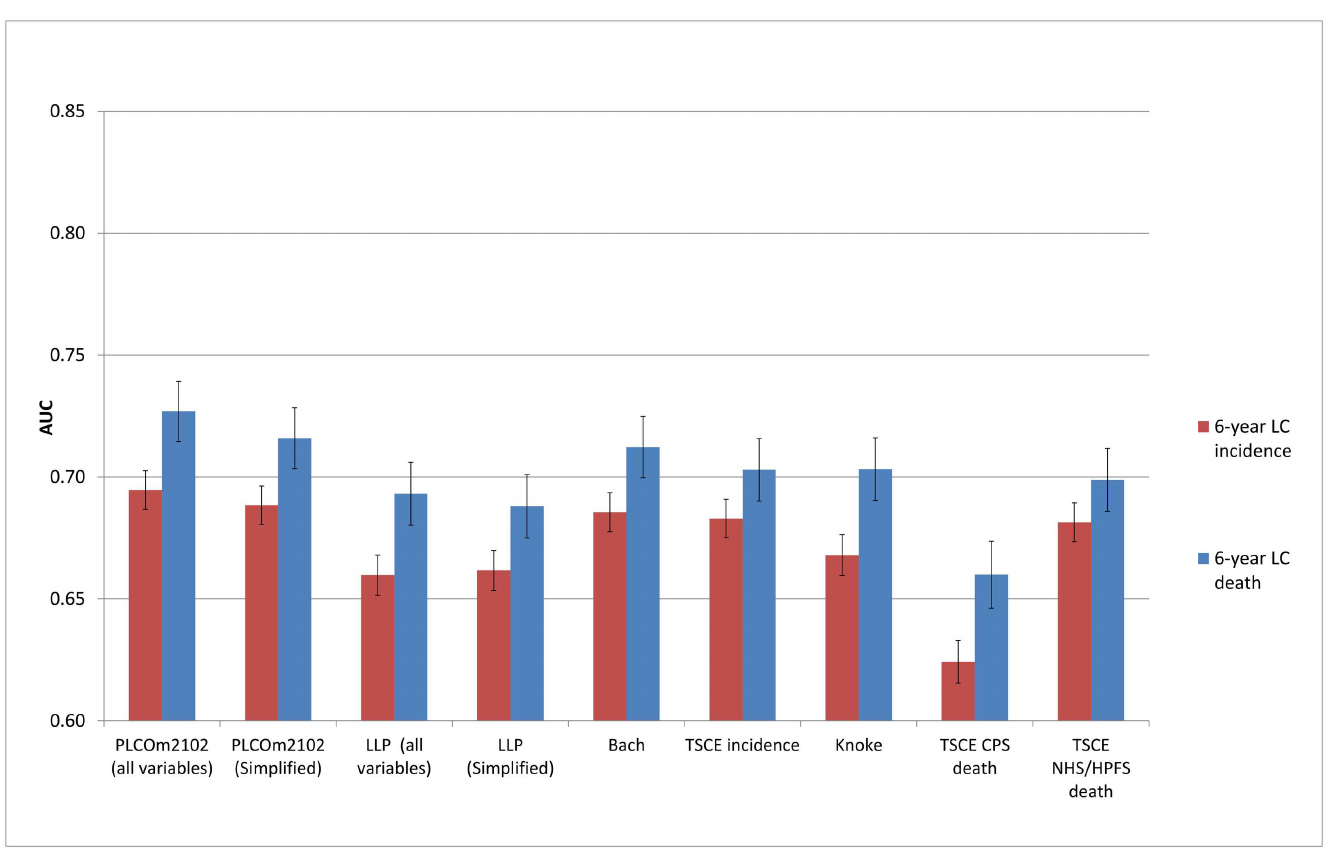
Fig 2. Area under the receiveroperating characteristic curve of the investigated risk models (with 95% confidence interval) in the National Lung Screening Trial computed tomography arm by predicted outcome. AUC, area under the receiveroperatingcharacteristic curve; CPS, Cancer PreventionStudy; HPFS, Health Professionals Follow-upStudy; LC, lung cancer; LLP, Liverpool Lung Project; NHS, Nurses’ Health Study; TSCE, Two- Stage Clonal Expansion.